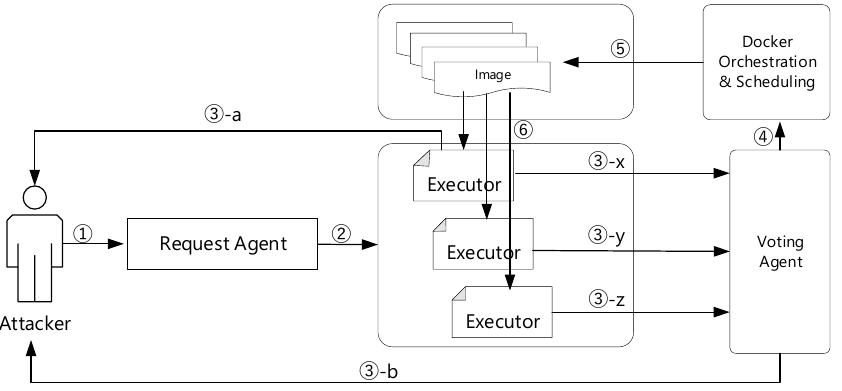
Figure 6. The process of hackers trying to attack the IoT microservice by sending